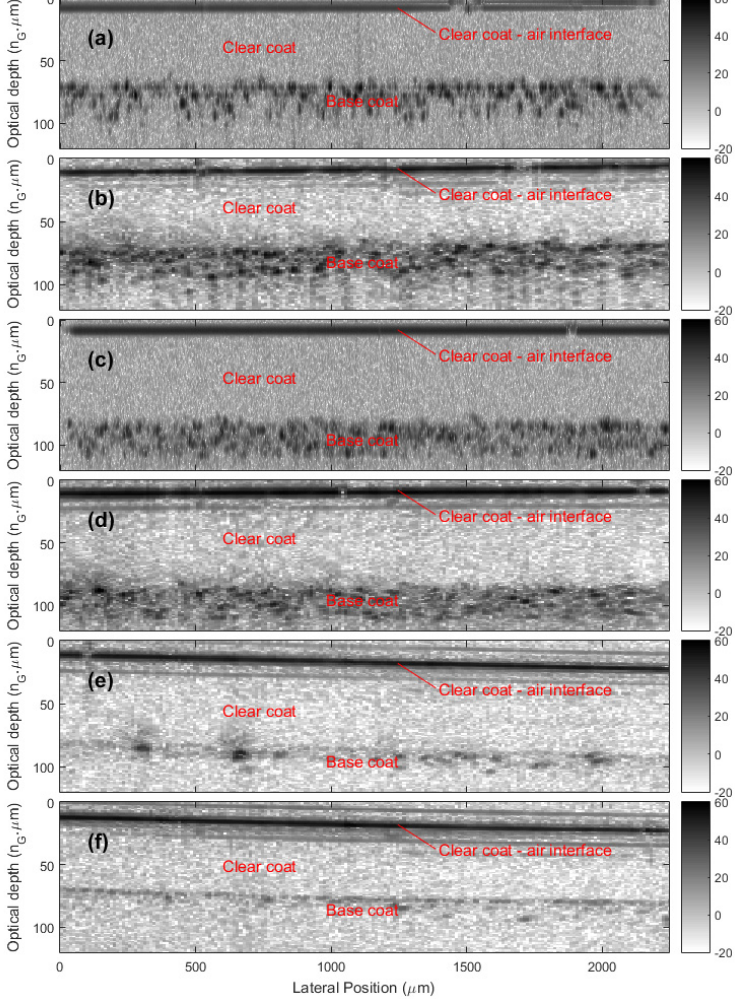
Figure 3. B-Scan images of Indus silver ( a , b ), Mauritius blue ( c , d ), Barolo black ( e ), and Santorini black ( f ) automotive metallic paint samplers. Taken with FF-TD ( a , c ) and LF-FD ( b , d – f ) parallel OCT systems. The FF-OCT B-Scans are taken from within 1 mm of the location of the corresponding LF-OCT images. Scaling is the same for all images. Colour bar units are dB.